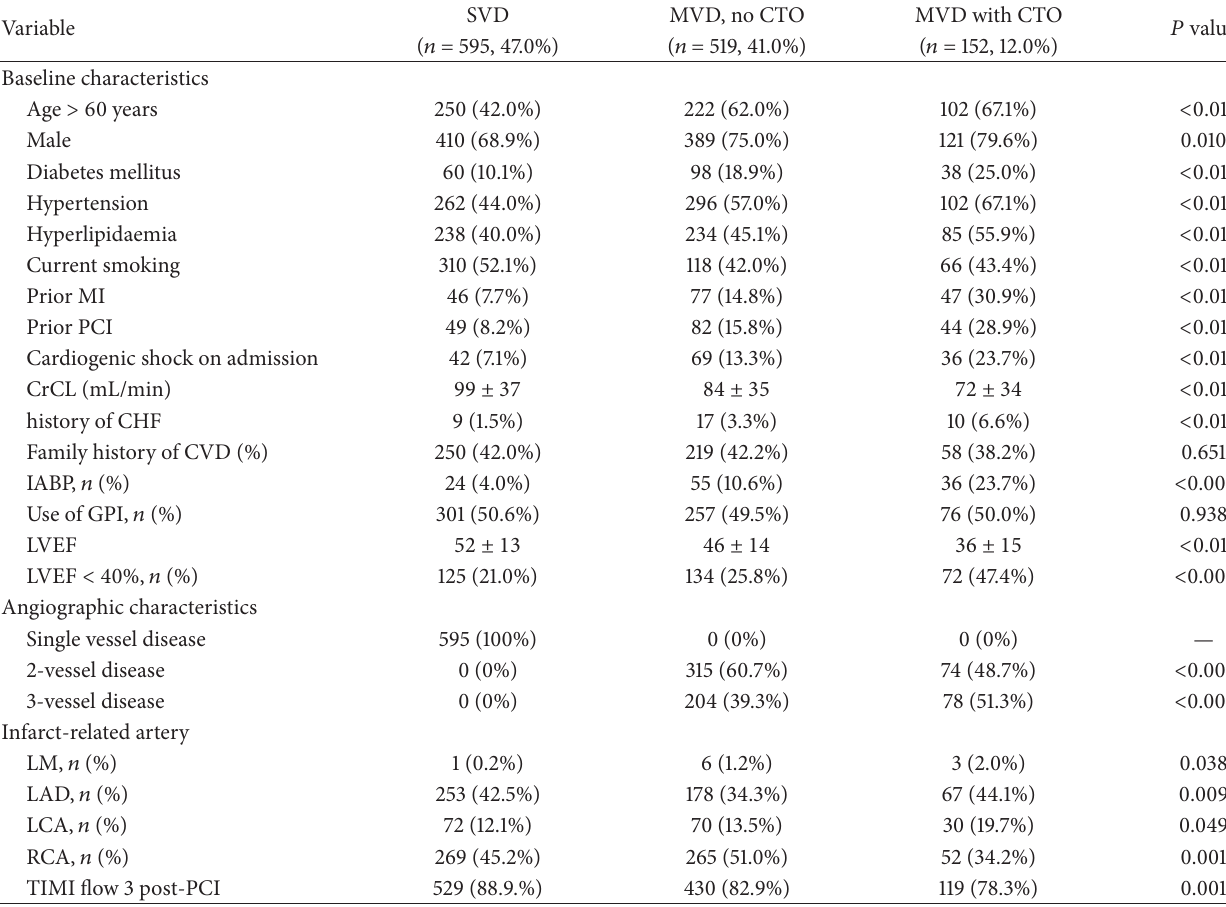
Table 1: Baseline clinical and angiographic